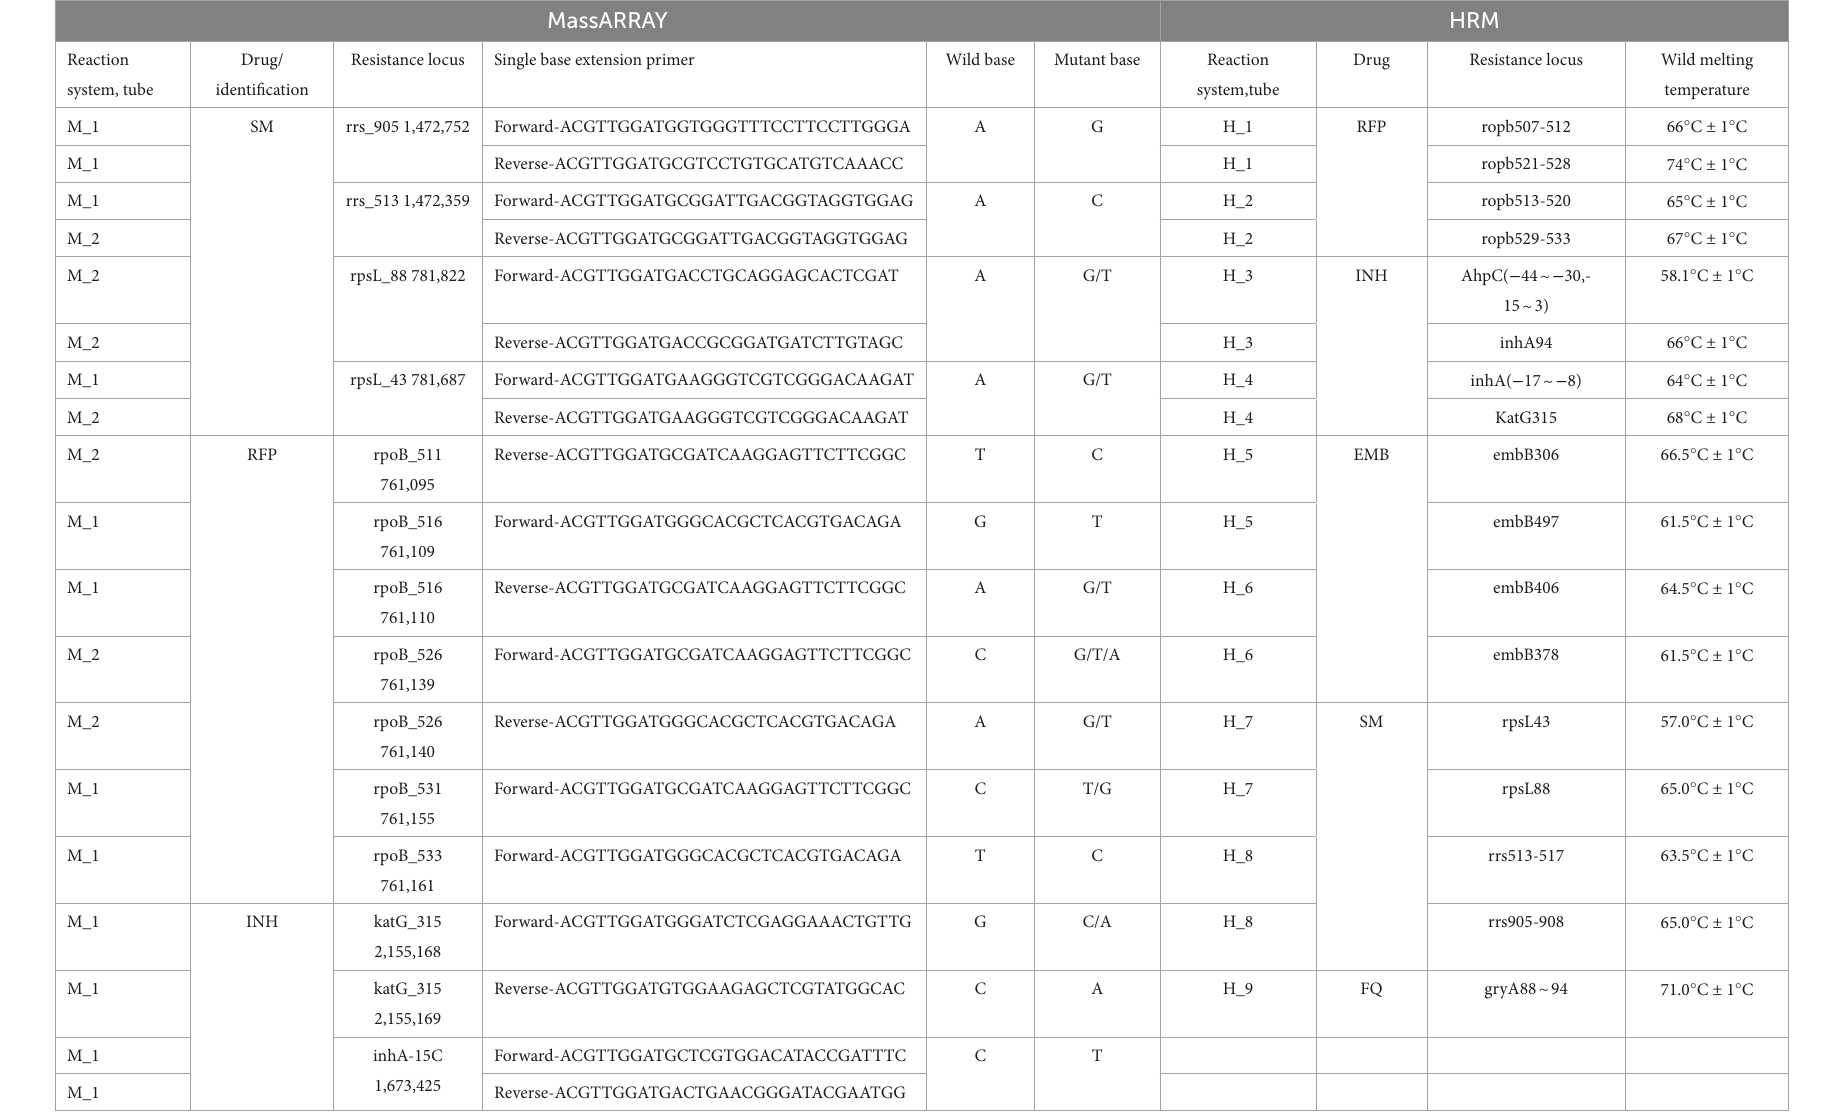
TABLE 1 Description of MassARRAY and HRM gene detection